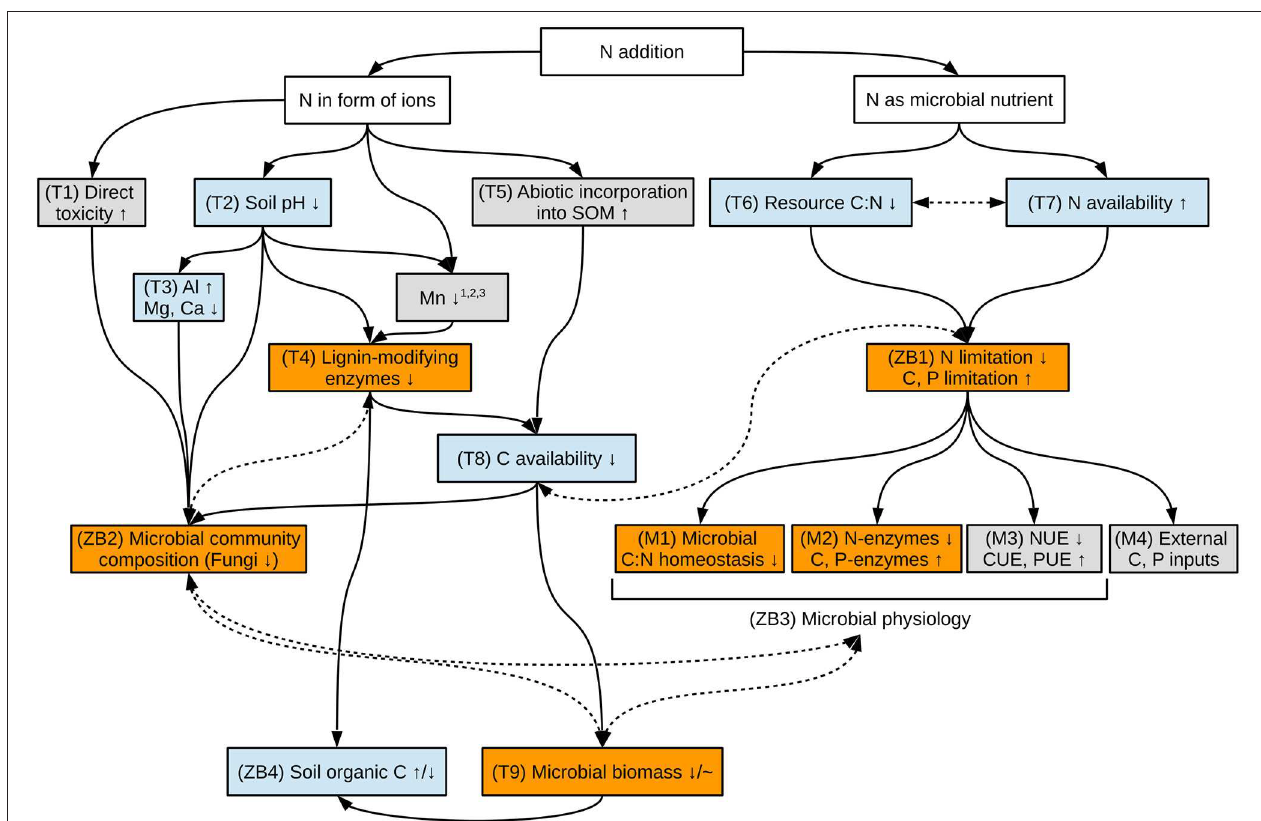
FIGURE 1 | Scheme of potential mechanisms by which added N can impact soil microorganisms and soil organic C. The conceptual model is based on Treseder (2008) (T1-9) and includes ideas from Mooshammer et al. (2014) (M1-4) and Zechmeister-Boltenstern et al. (2015) (ZB1-4). Orange boxes highlight mechanisms studied in this contribution and are described in more detail the main text. Blue boxes highlight mechanisms studied by Forstner et al. (2019) at the same experimental sites. Gray boxes highlight mechanisms yet unstudied at these experimental sites. Continuous, single-headed arrows between boxes indicate hypothesized cause-effect relationships. Dashed, double-headed arrows between boxes indicate hypothesized feedback-loops. Up- and downward arrows within boxes indicate hypothesized increases and decreases of the respective parameters upon N addition, respectively, while the tilde indicates unchanged microbial biomass in case of physiological adaptations to added N. References relating N addition to Mn availability are Turlapati et al. (2013) (1), Berg et al. (2015) (2), and Whalen et al. (2018)